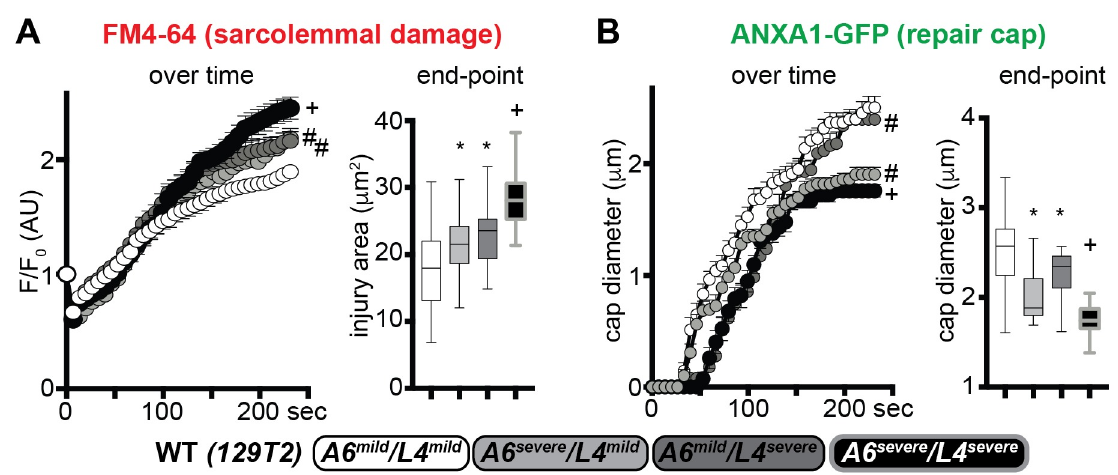
Fig 8. Relative contribution of Anxa6 and Ltbp4 alleles on sarcolemmal repair in wildtype muscle. In addition to Ltbp4 , Anxa6 has also been shown to modify muscular dystrophyin mice [25, 45]. The deleteriousallelesof Ltbp4 (L4) or Anxa6 (A6) (severe) were compared to those from the protective 129 strain (mild) in the sarcolemma injury assay. A) Doublyhomozygous A6 mild /L4 mild myofibers had the least injury whiledoubly homozygous A6 severe /L4 severe fibers had the greatest injury, marked by FM4-64. Myofibers with mixed homozygous genotypes were intermediatewith respect to FM4-64 marked injury. B) A similar pattern was observedfor AnnexinA1 (ANXA1) repair caps, where doublyhomozygousmild allelesof L4 and A6 assembled caps more rapidly and produced larger repair caps than doublyhomozygoussevere alleles. However, ANXA1 repair caps were smaller with the A6 homozygous severe allele, despite the presence of the mild L4 allele, suggestingthat repair cap formation is dominated by the A6 genotype. FM4-64 and ANXA1-GFP images used for the analysesin A-B were acquiredsimultaneously. Marked line plots, avg ± sem; box plots, Tukey distribution; n = 50 myofibers (5 mice)/group; marked line plots: #, P < 0.05vs control (A6 mild /L4 mild ), +, P < 0.05vs A6 severe /L4 mild and A6 mild /L4 severe groups, 2way ANOVA + Bonferroni; boxplots: * , P < 0.05vs control (A6 mild /L4 mild ), +, P < 0.05vs A6 severe /L4 mild and A6 mild /L4 severe groups, 1way ANOVA + Bonferroni.